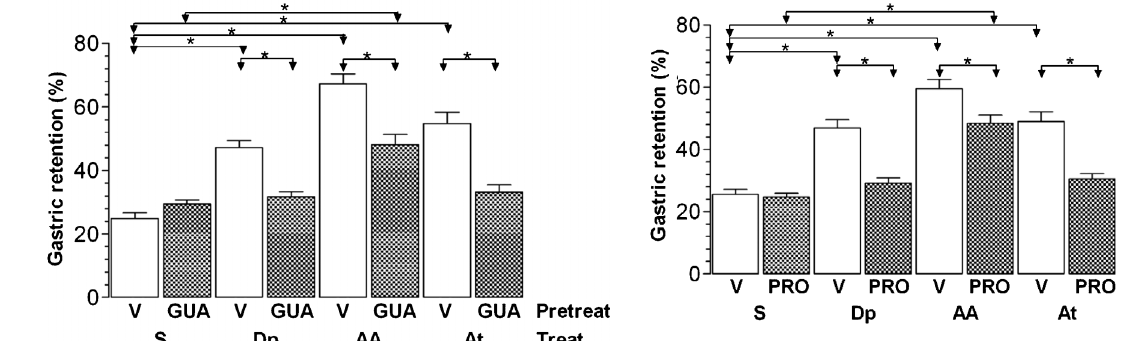
Figure 1. Gastric retention (%) of a saline test meal 10 min after administration to rats by gavage. The animals were pretreated (Pretreat) sc with saline as a vehicle (V) or with guanethidine sulfate (GUA, 100 mg ? kg -1 ? day -1 ) for 2 days before the iv treatments (Treat) with saline (S) or 240 m mol/kg dipyrone (Dp), 4-aminoantipyrine (AA) or antipyrine (At). The test meal was administered 10 min after the treatment. Data are reported as means±SE for 8 animals per group. *P , 0.05 (Tukey test).